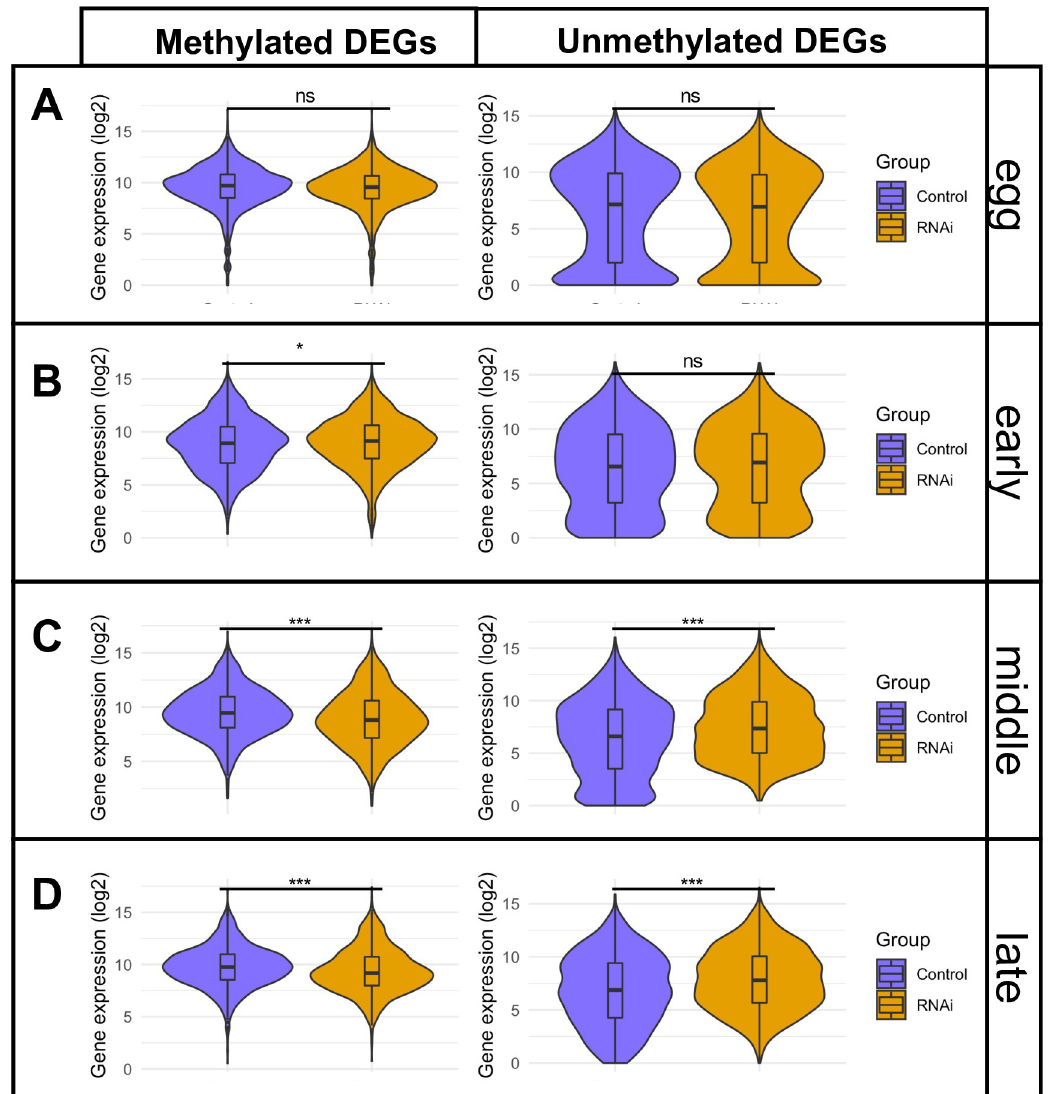
Fig 5. Violin plots of methylated and unmethylated differentially expressed genes (DEGs) in control and Nv-dnmt1a pRNAi samples. (A) eggs, (B) early blastoderm embryos, (C) middle blastoderm embryos, and (D) late blastoderm embryos. p-values were determined by performing a 2-tailed T-test assuming unequal variance between RNAi and control. ns = not significant (P > 0.05). � = P < 0.05. ��� = P < 0.0001).